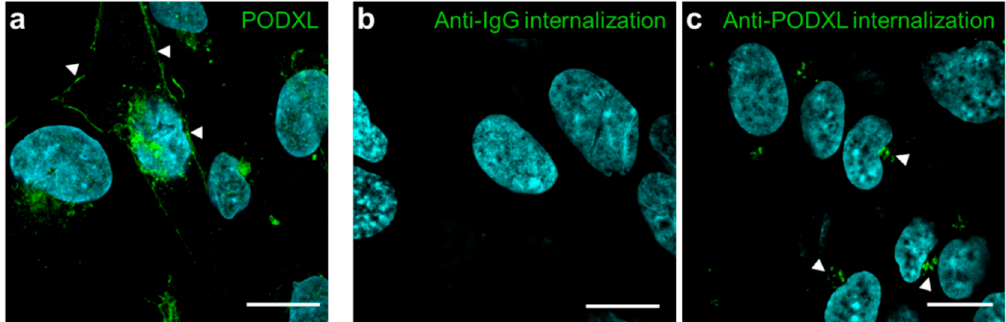
Figure 7. Localization and internalization of cell-surface PODXL into hCMEC/D3 cells. ( a ) Immunohistochemical analysis of PODXL in hCMEC/D3 cells was performed using an anti-PODXL antibody (green). Nuclei were stained using DAPI (blue). The images were obtained by confocal microscopy. Arrow heads show PODXL in the plasma membrane. ( b , c ) Internalization of cell-surface PODXL into hCMEC/D3 cells. The cells were treated with fluorescein (FL)-labeled anti-IgG (green, b ) or FL-labeled anti-PODXL antibody (green, c ) on ice for 30 min and then incubated at 37 °C for 5 min. Arrow heads show the internalized PODXL. Nuclei were stained using DAPI (blue). Scale bars: 20 μ m.